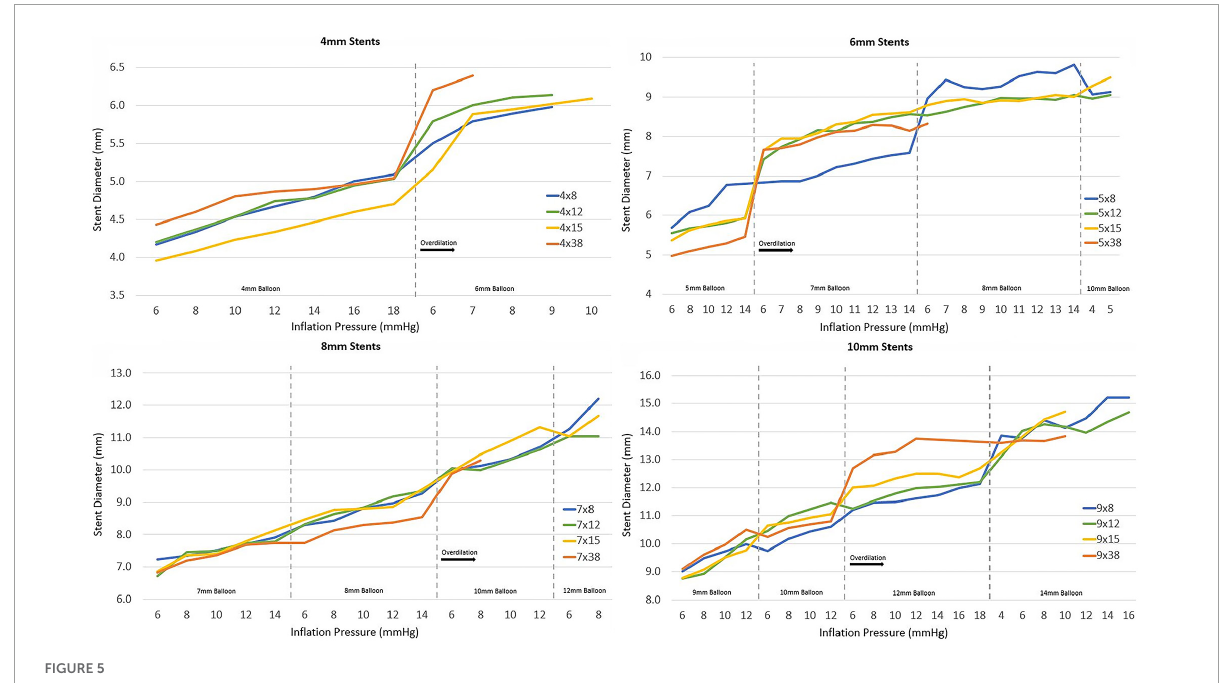
FIGURE5 Mean stent diameter with dilation and overdilation until first strut fracture.